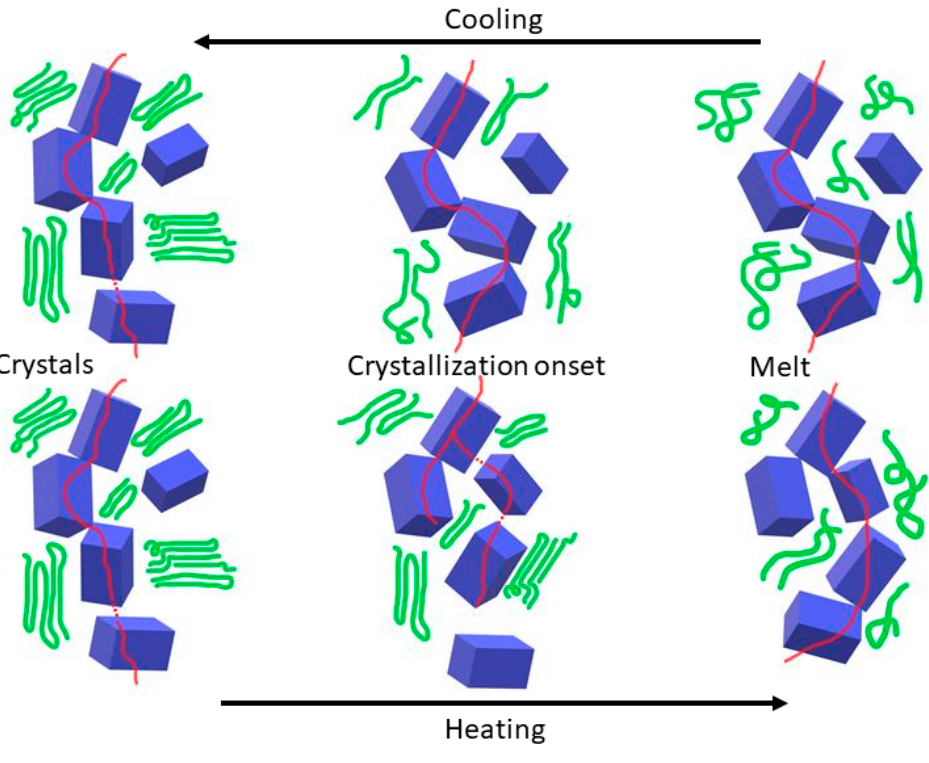
Figure 7. Schematic representation of the integrity of the GNP network (blue) under cooling and heating, indicating the crystalline phase (green) and the percolative network (red line).